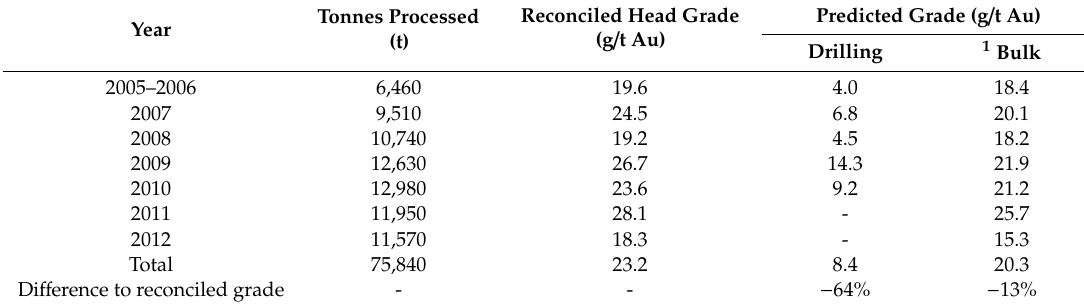
Table 24. Reconciliation between reconciled plant head grade and diamond drill core and bulk sample estimates for the 2005–2012 period. All estimated grades account for intentional and unintentional